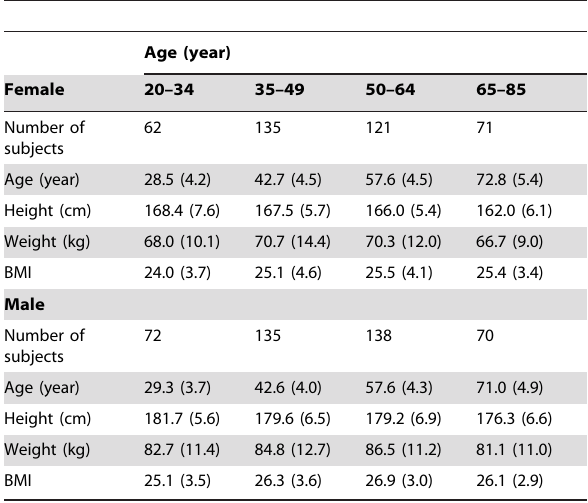
Table 1. Baseline characteristics of the participants by 15- year age cohort for female and male (SD).